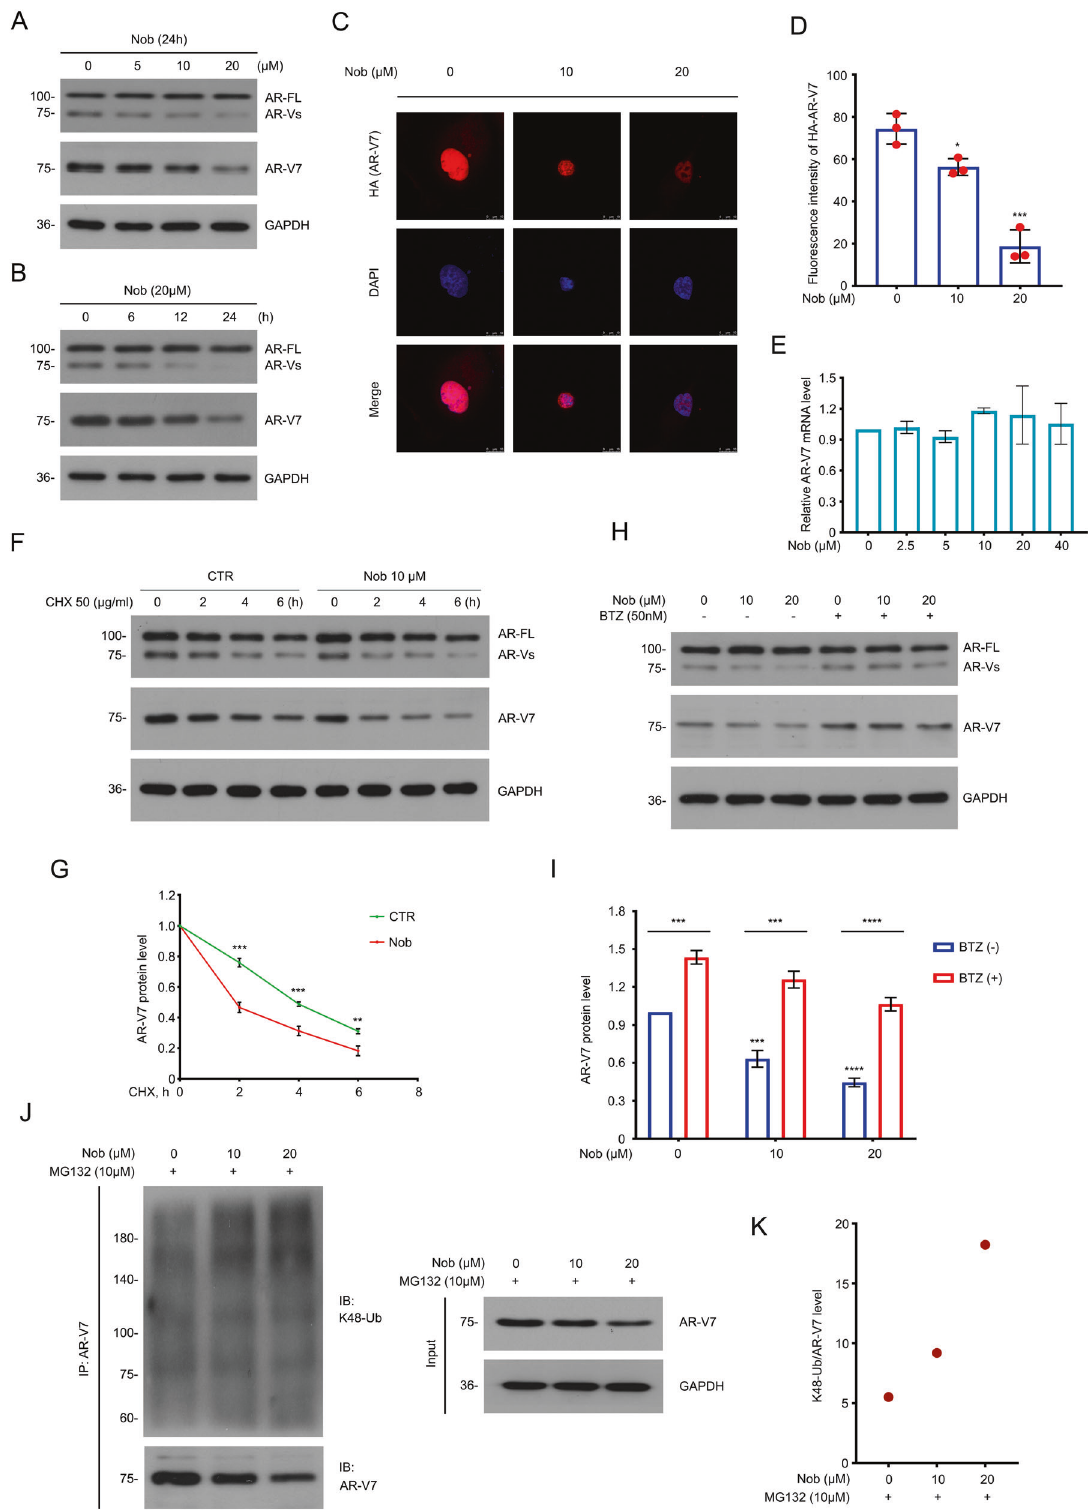
Fig. 3 Nobiletin functioned as a selective inducer for degradation of AR-V7. A Western blot of AR and AR-V7 in 22Rv1 cells exposed to nobiletin for 24 h. B Western blot analysis of AR and AR-V7 in 22Rv1 cells exposed to nobiletin (20 μ M) for different lengths of time. C Immuno fl uorescence assay was performed using HA-tag antibody in 22Rv1 cells transfected with HA-AR-V7 plasmids for 48 h and exposed to nobiletin for 24 h. D Quantitative data of C are shown. Mean ± SD ( n = 3). E Real-time quantitative PCR analysis of AR-V7 in 22Rv1 cells treated with nobiletin for 6 h. F Western blot of AR and AR-V7 protein level in 22Rv1 cells treated with nobiletin (10 μ M) or DMSO for 12 h, and then exposed to cycloheximide (CHX). G Quantitative data of F are shown. Mean ± SD ( n = 3). H Western blot analysis of AR and AR-V7 in 22Rv1 cells exposed to nobiletin with or without Bortezomib (BTZ) for 12 h. I Quantitative data of H are shown. Mean ± SD ( n = 3). J Co-IP assay was performed using AR-V7 antibody and immunoblotted for K48-Ub and AR-V7 in 22Rv1 treated with nobiletin for 12 h, and exposed to MG132(10 μ M) for 6 h before harvest. K Quanti fi cation of K48-ubiquitination levels of AR-V7 for J